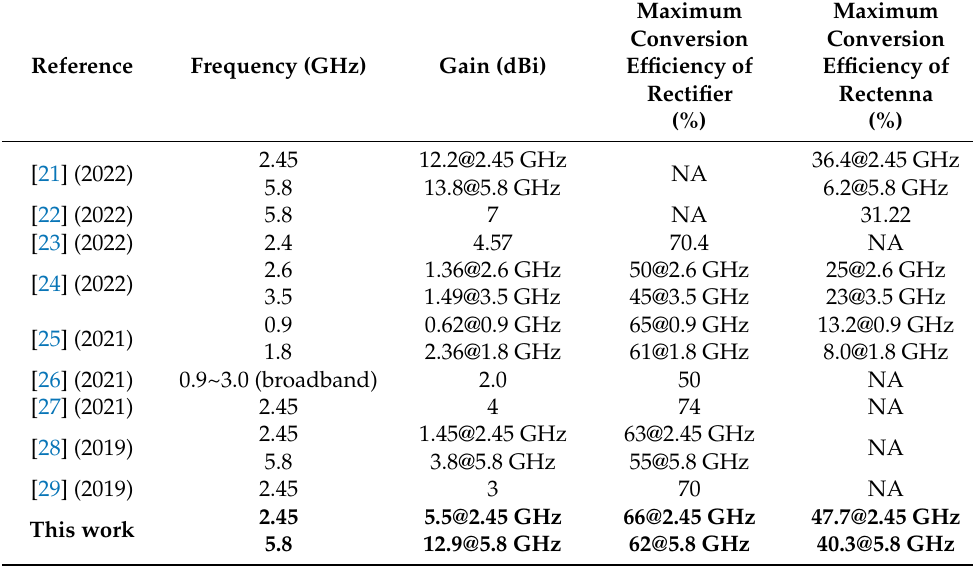
Table 3. Comparison of the proposed rectenna and similar reported